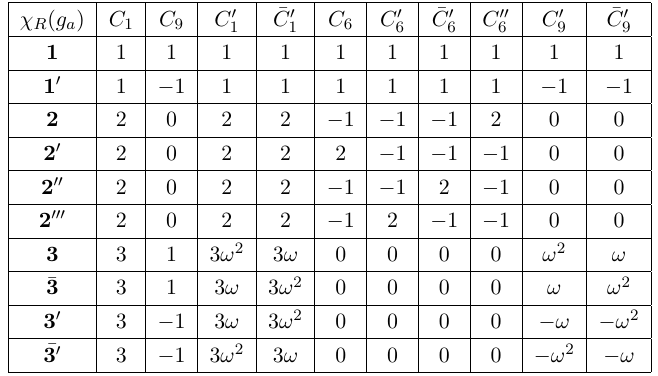
Table 3 . Character table for G = ( Z 3 (cid:2) Z 3 ) o S 3 . The subscripts of the conjugacy classes indicate their size, and ! = e 2 (cid:25) i = 3